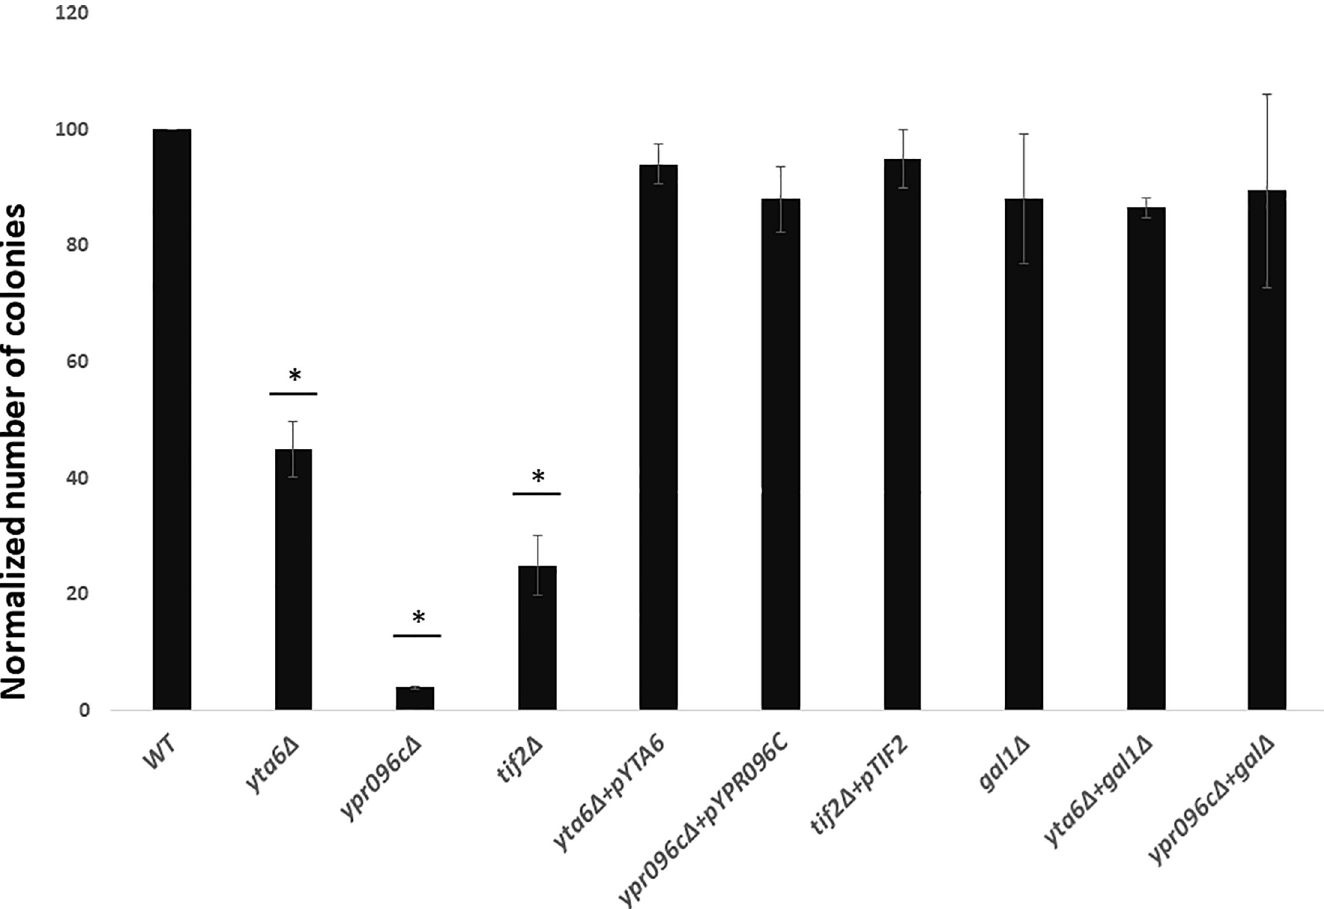
Fig 2. Quantitative analysis of drug sensitivity for different yeast strains. The average number of colonies formed for different yeast strains in the presence of LiCl (10 mM) was normalized to that for the WT strain (WT average colony count = 285.33). Double deletion for GAL1 with YTA6 or YPR096C suppressed the observed sensitivity of single-gene deletions for YTA6 or YPR096C . Data represent the average from three independent experiments (n = 3) and error bars represent standard deviation. � represent statistically significant results compared to the WT. t-test analysis ( P -value � 0.05) was used to compare differences.